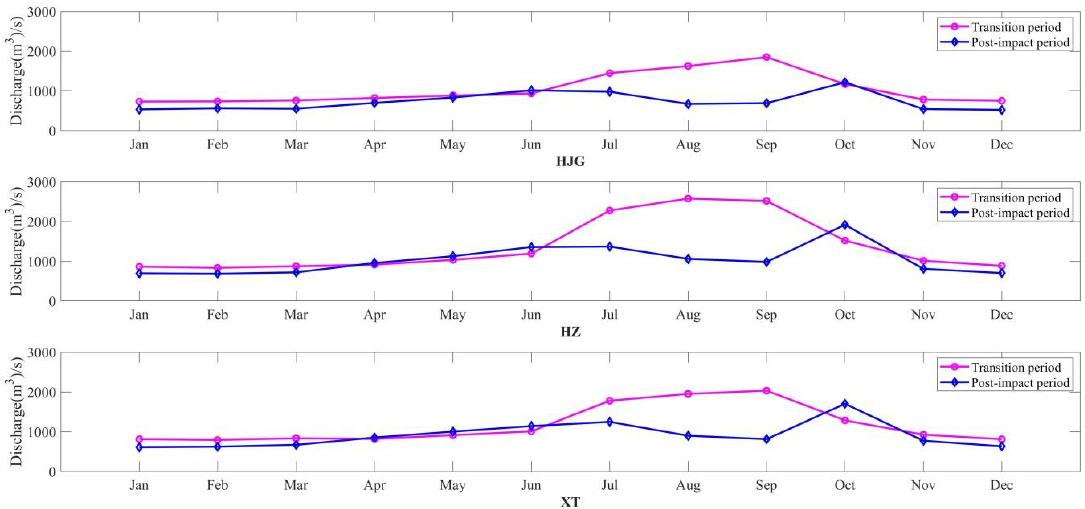
Figure 11. Average monthly flow at HJG, HZ and XT between the transition and post-impact periods.